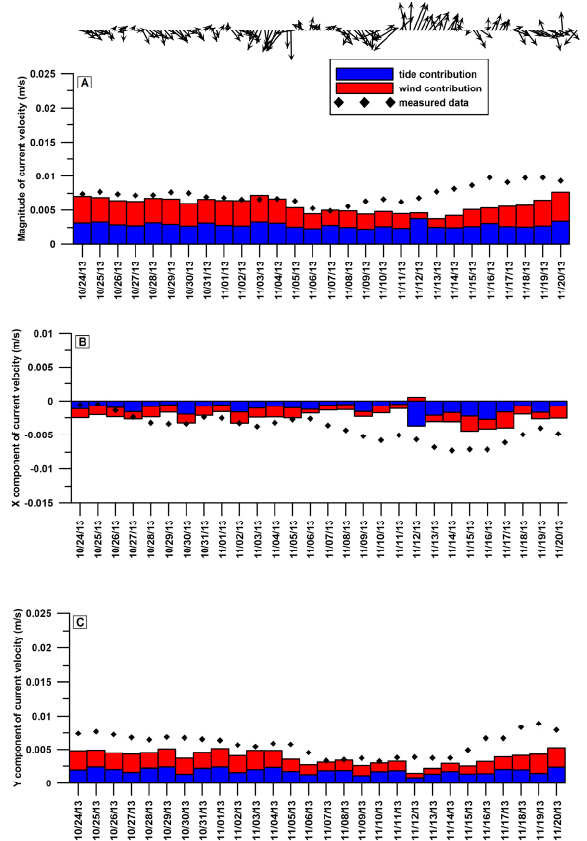
Figure 3. Comparison between model (bars) and measured (black points) current speeds (magnitude, ( A ), and its components, ( B ) and ( C )) at the ADP station. The contribution of tide (blue) and wind (red) is also reported. The arrows shown in the upper panel point in the direction in which the wind was